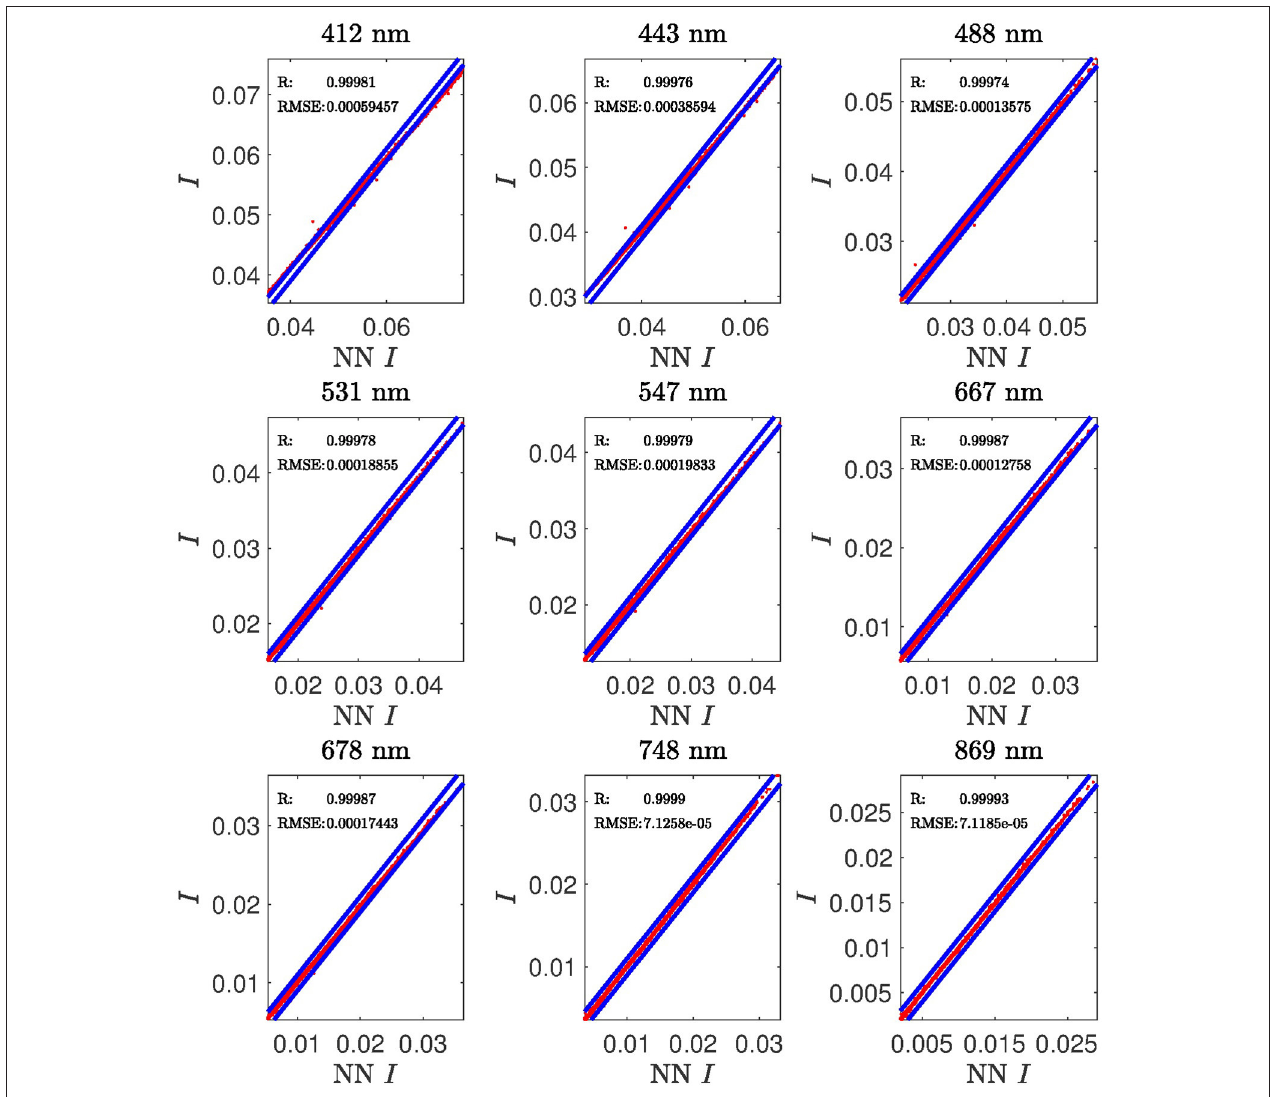
FIGURE 2 | Comparison of RBF-NN forward model results for I with C-VDISORT results for the nine MODIS VIS channels used in this